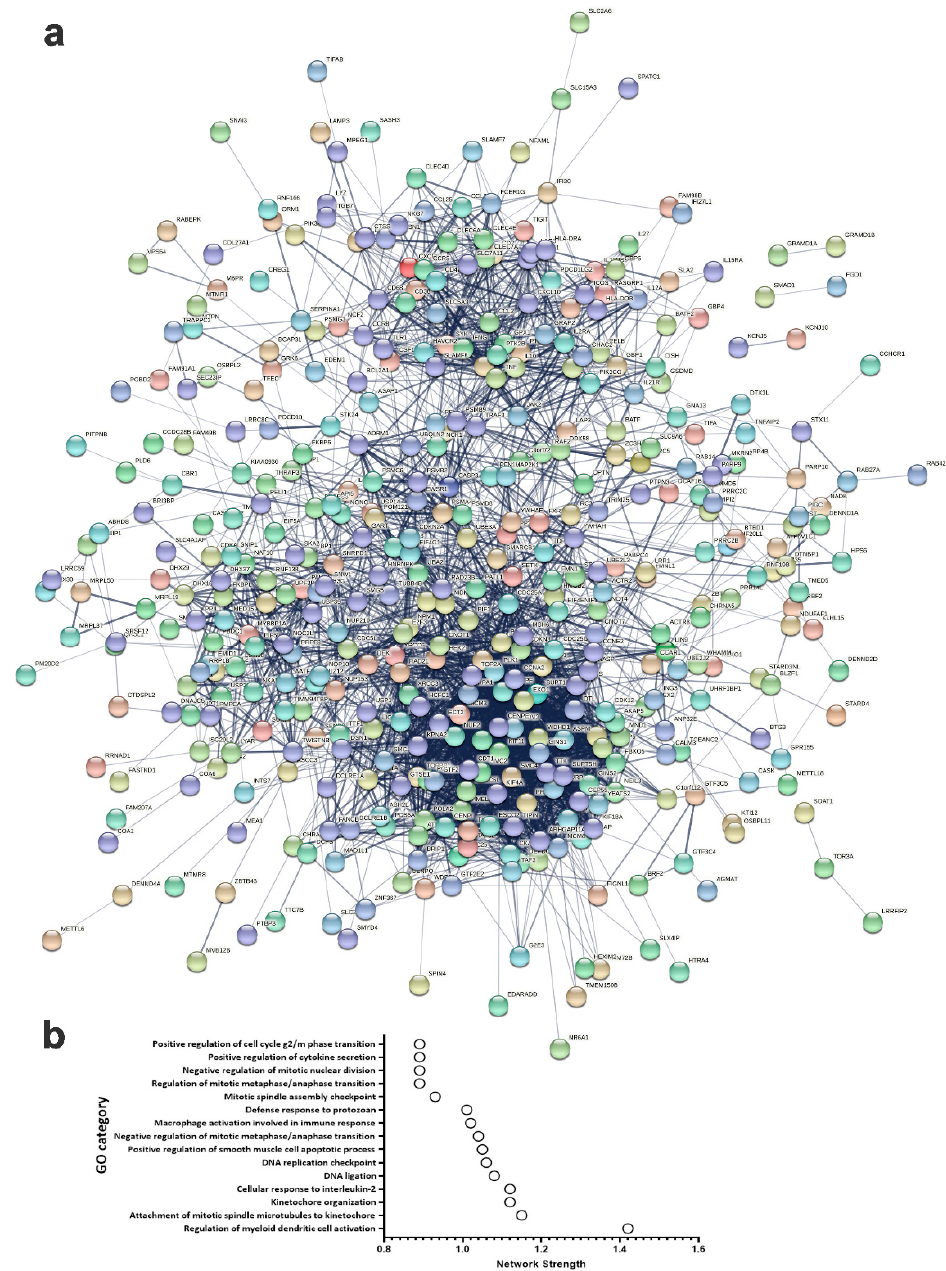
Figure 6. PPI network analysis of mRNAs predictive of pCR. ( a ) The 500 common mRNAs identi- fied through ROC analysis predicative of pCR in the discovery and validation cohorts were subjected to PPI network analysis using the STRING database. Network statistics: number of nodes: 500; number of edges: 3256; average node degree: 13; avg. local clustering coefficient: 0.402; expected number of edges: 1631; PPI enrichment p -value: <1.0 × 10 − 16 . ( b ) Bar graph illustrating the top 15 enriched gene ontology (GO) categories ( y -axis) with network strength score presented on the x - axis.